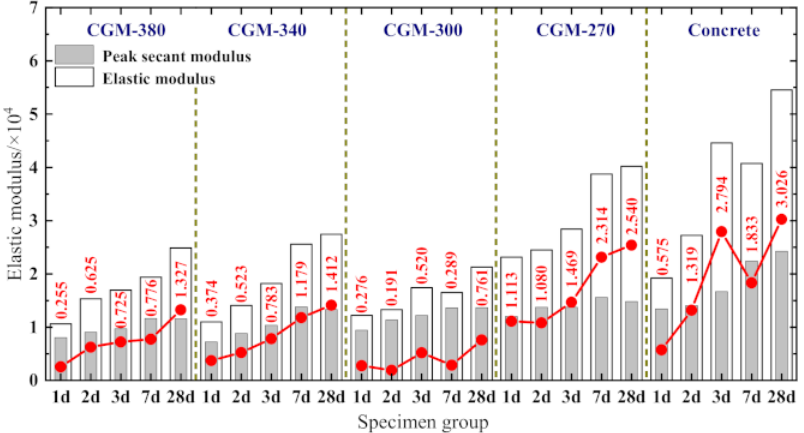
Figure 6. Discrepancies between peak secant modulus and elastic modulus.